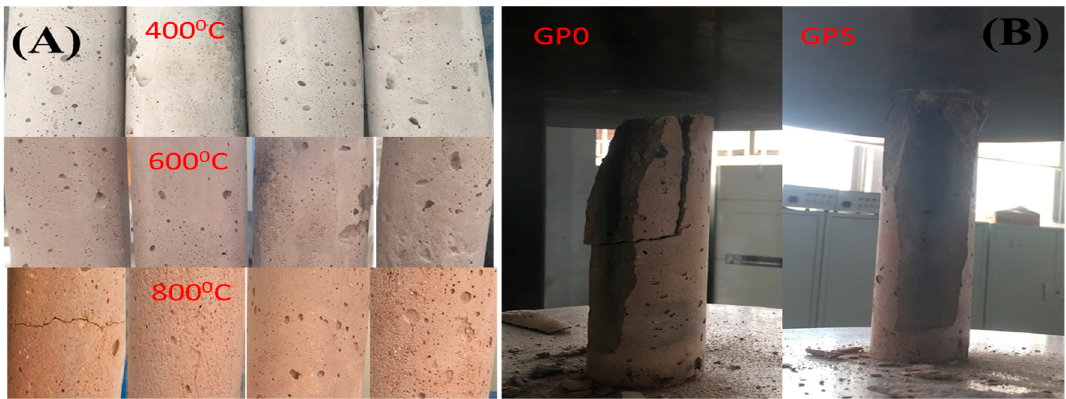
Figure 8. ( A ) Color changes at different temperatures in all the geopolymer specimens: GP0 to GP7 specimens (left to right, respectively); ( B ) fracture pattern.